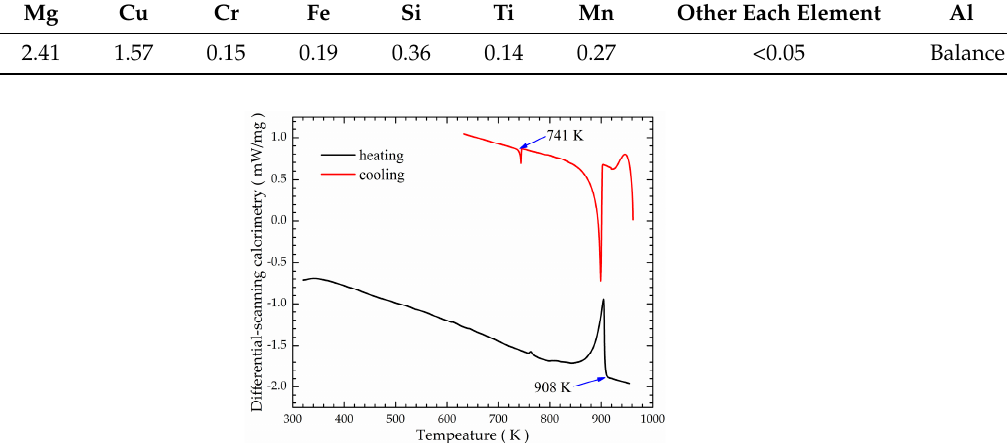
Figure 5. The composition measurement points from C 1 to C 9 and the metallographic samples positions (M 1 , M 2 and M 3 ) on the disk piece.